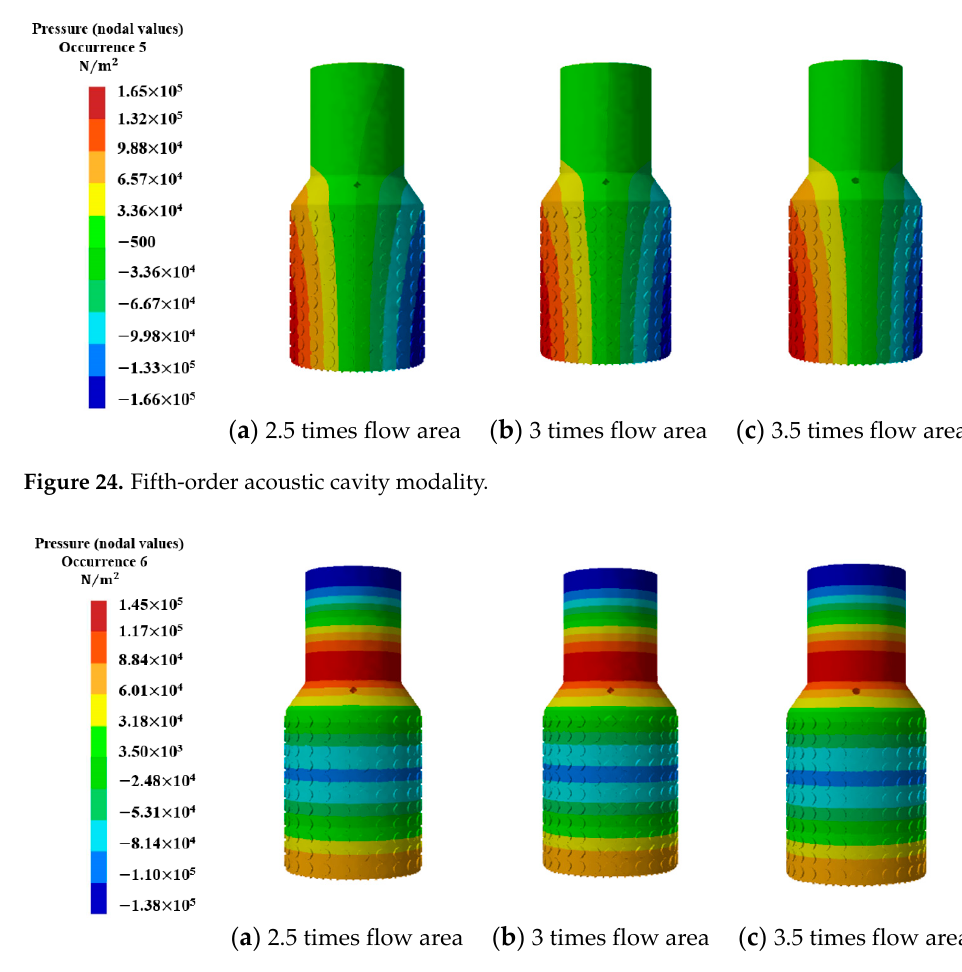
Figure 23. Fourth-order acoustic cavity modality.